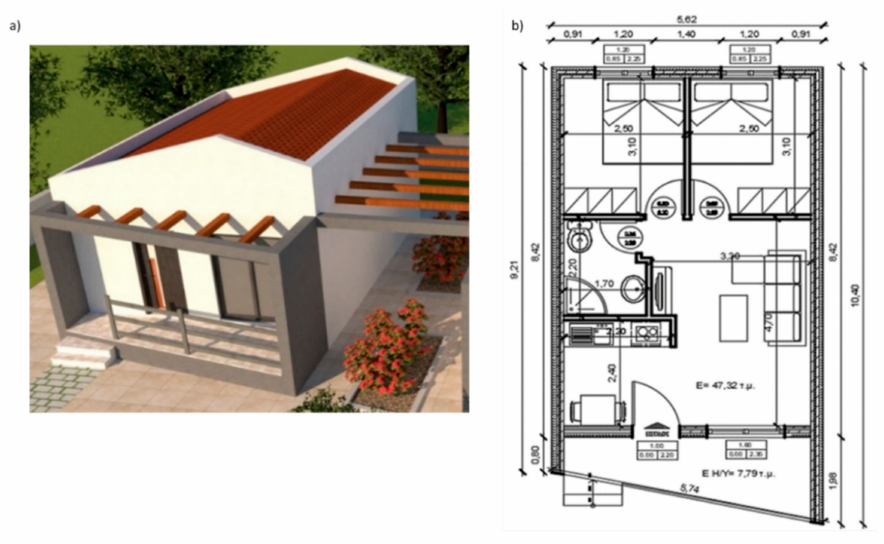
Figure 1. ( a ) External 3D view and ( b ) plot of the examined